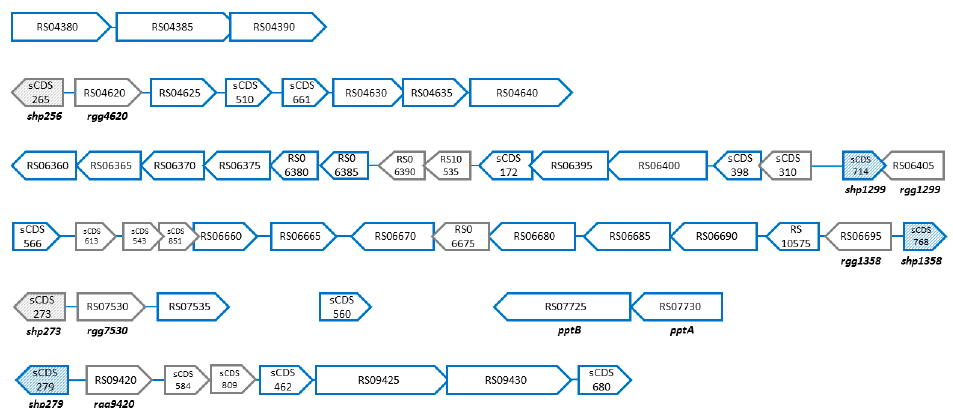
Figure 3. Organizational schematic of the genes controlled by PptAB. The genes whose expression was upregulated in the TIL1560 strain ( comR :: aphA3 ) compared to the TIL1562 strain ( comR :: aphA3 Δ pptAB ) are shown in blue. This set of genes was controlled by PptAB but did not include genes regulated by ComR, which controls competence. ORF orientation within each cluster is indicated by the direction of the arrowhead (not to scale). Genes encoding SHPs have hatched shading. Genes that were not regulated by PptAB are in gray. Genes were named and described in accordance with their GenBank annotations, to which we added in-lab annotations for the short genes (see the Materials and methods section and Table S3).